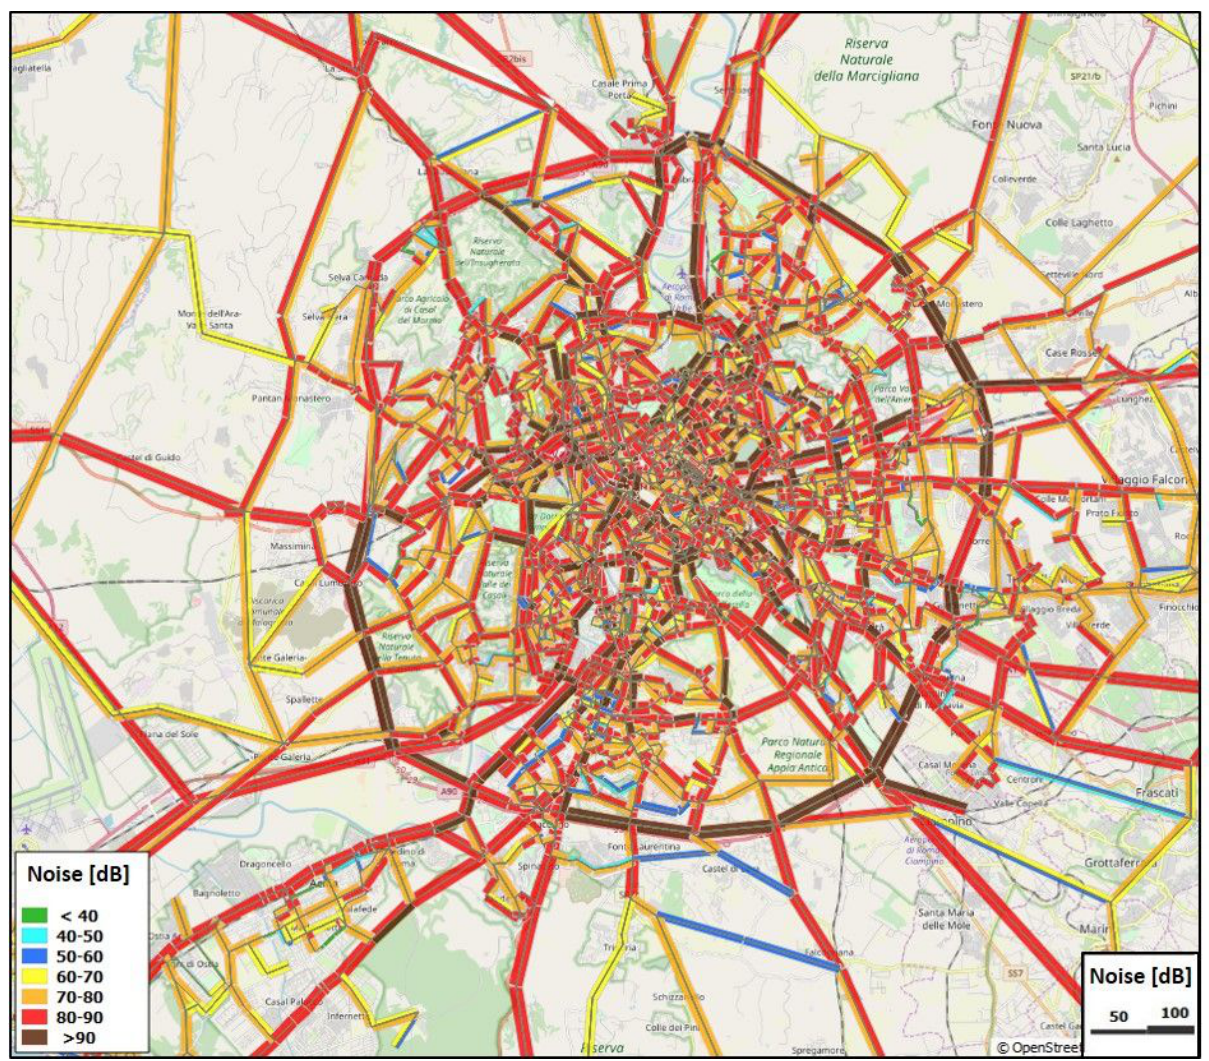
Figure 2: Noise emissions [dB], Current scenario